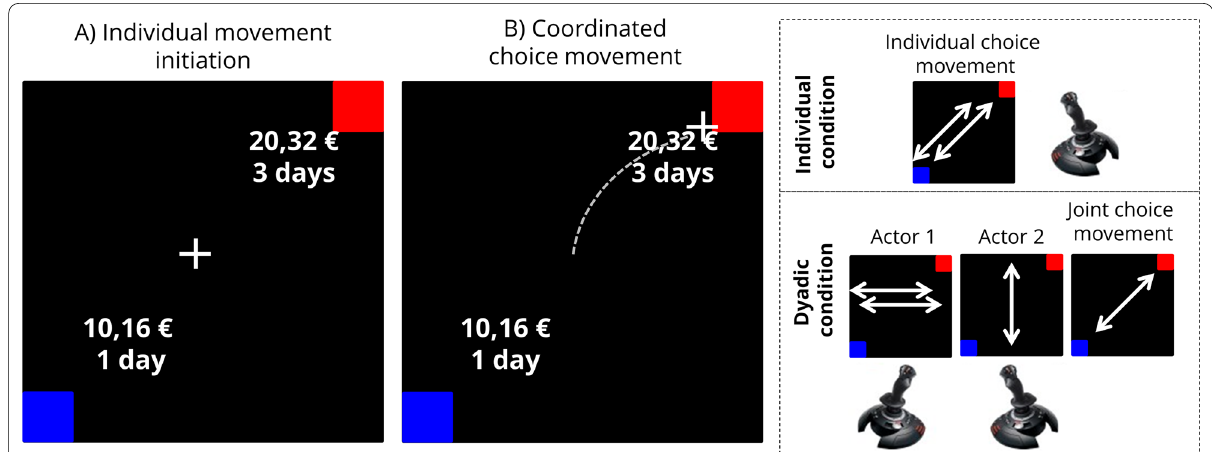
Fig. 1 Sketch of the experimental screen and procedure. Left: each trial started with the presentation of the value in euros and the delay in days, and the cursor was locked in the centre of the screen. To select an option, the participants navigated the cursor into the colour-coded response box in the upper right/ lower left corner. Right: in the individual condition, each participant could reach their favoured response box by executing a diagonal joystick movement. In the dyadic condition, movement directions were split up to one participant controlling the vertical movement and the other controlling the horizontal movement while ignoring the other dimension. Because both cursor movements were added, the participants were able to move the jointly controlled cursor freely on the screen, comparable to the diagonal joystick movement in the individual